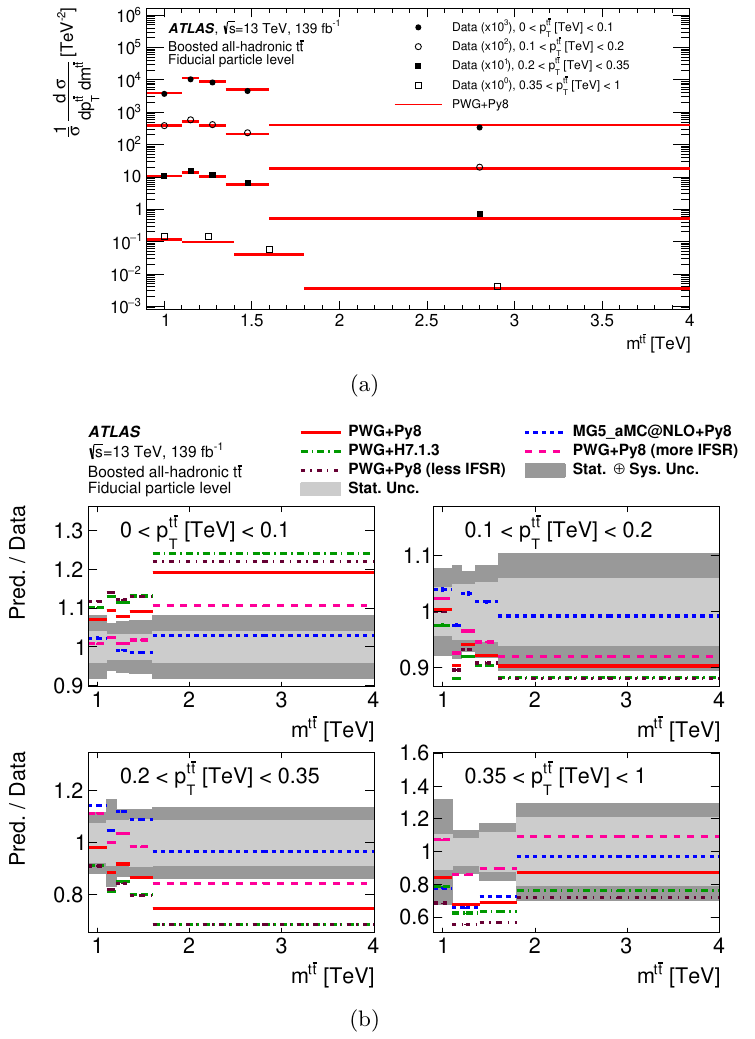
Figure 18 . (a) Normalized particle-level fiducial phase-space double-differential cross-sections as a function of the p T and the mass of the t ¯ t final state, p t ¯ t and m t ¯ t , compared with the T Powheg+Pythia 8 calculation. Data points are placed at the centre of each bin and the Powheg+Pythia 8 calculation is indicated by solid lines. The measurement and the predic- tion are normalized by the factors shown in parentheses to aid visibility. (b) The ratios of various MC calculations to the normalized particle-level fiducial phase-space differential cross-sections. The dark and light grey bands indicate the total uncertainty and the statistical uncertainty, respectively, of the data in each